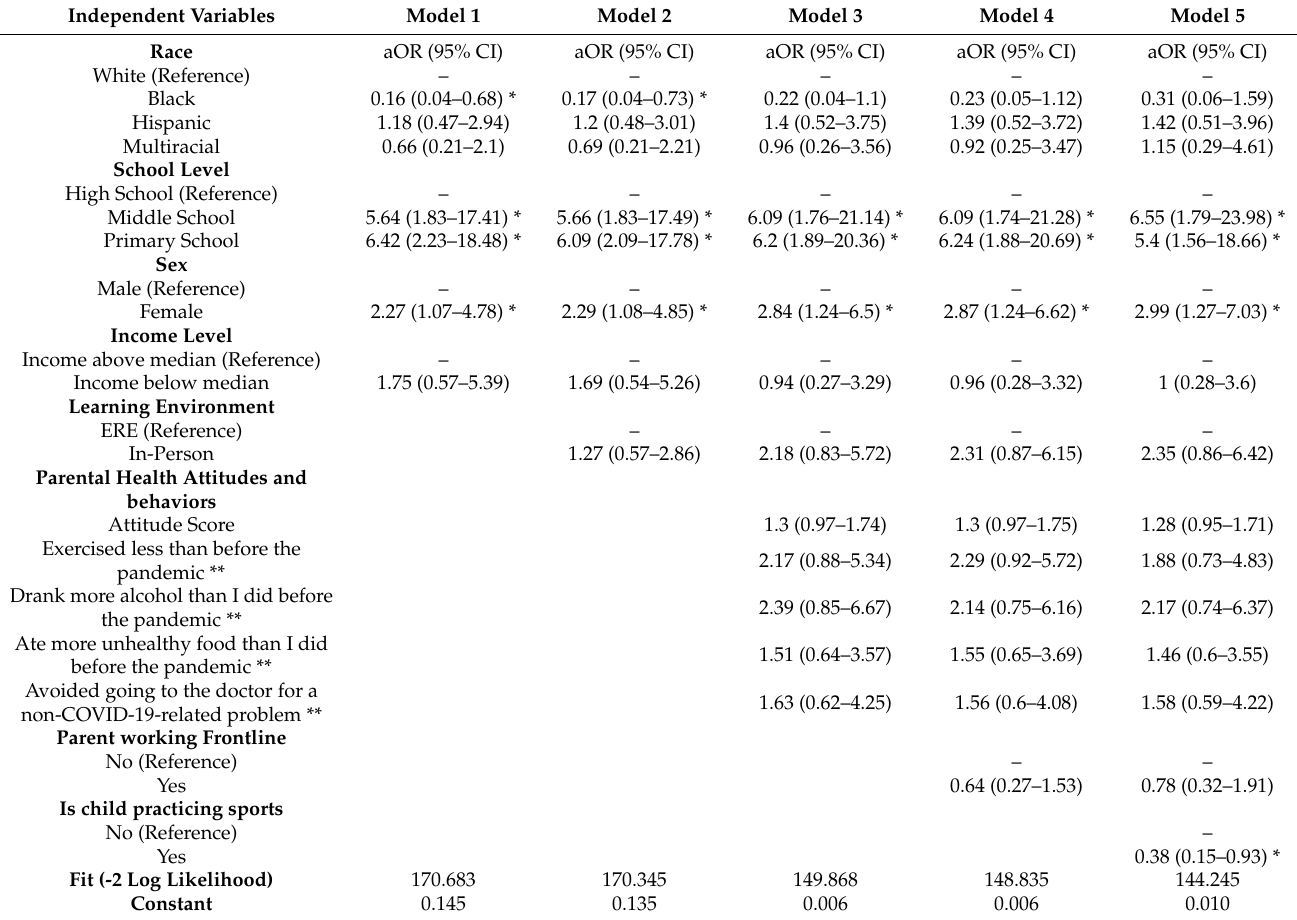
Table 3. Nested Logistic Regression Models Examining the Effects of Sociodemographic Characteristics, Learning En- vironment, Parental Health Attitudes and Behaviors, and other Selected Factors on Students Presenting as At Risk for